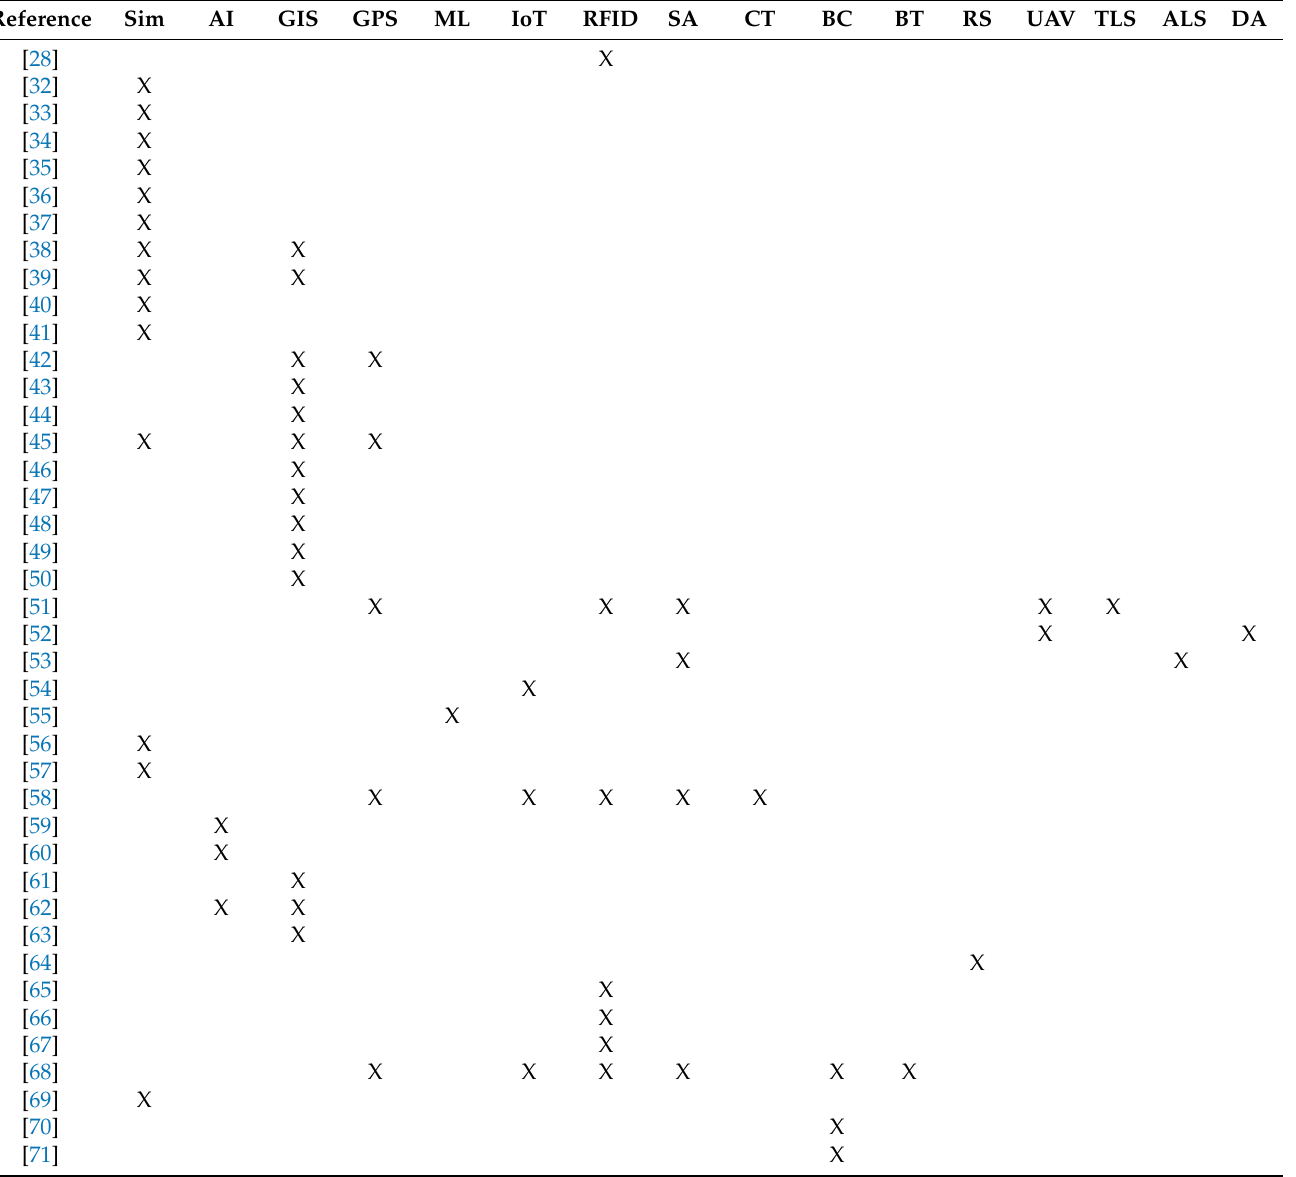
Table 2. Technologies considered by the authors of the included